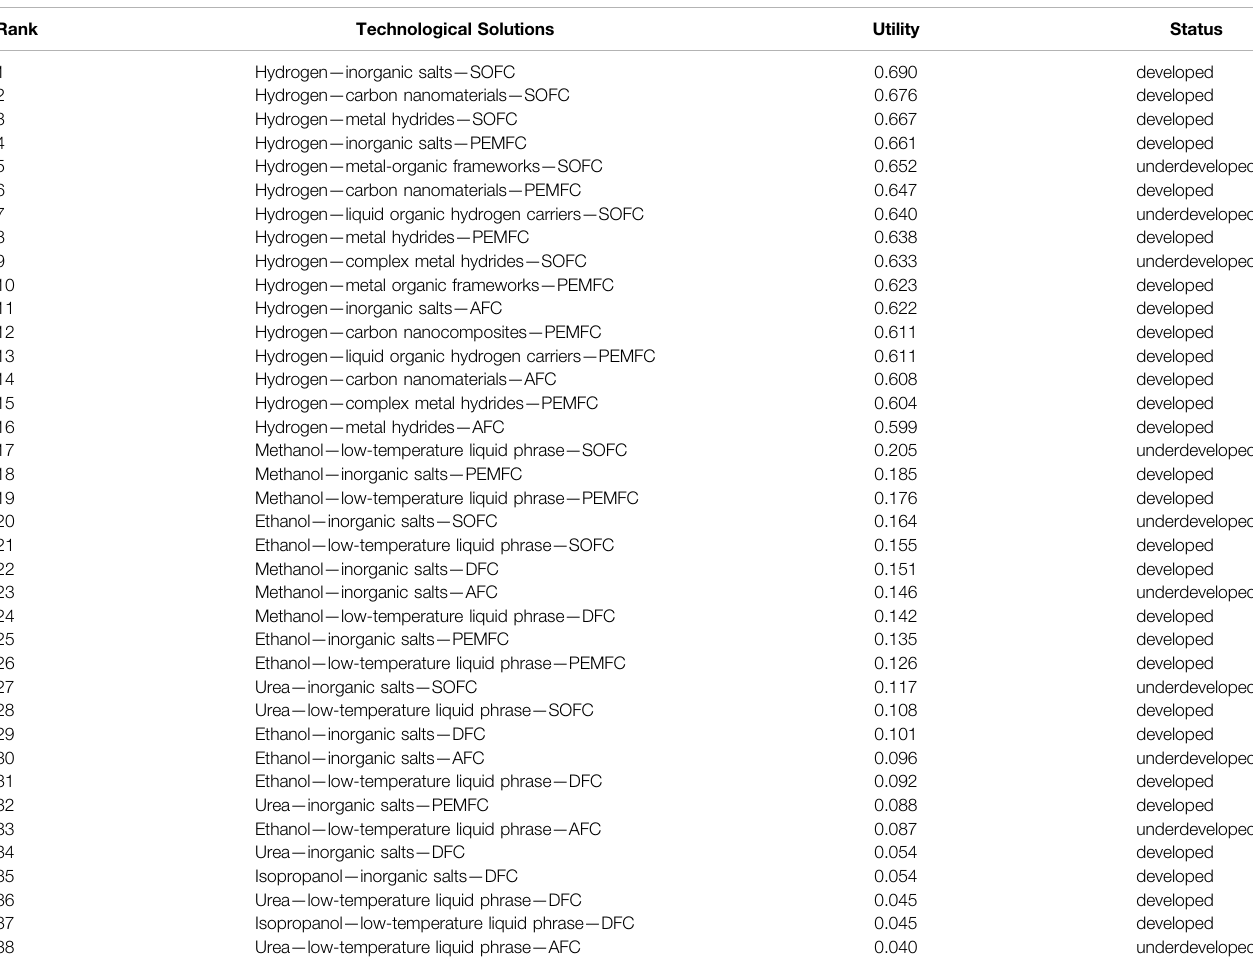
TABLE 4 | Utility levels of 38 technological solutions.